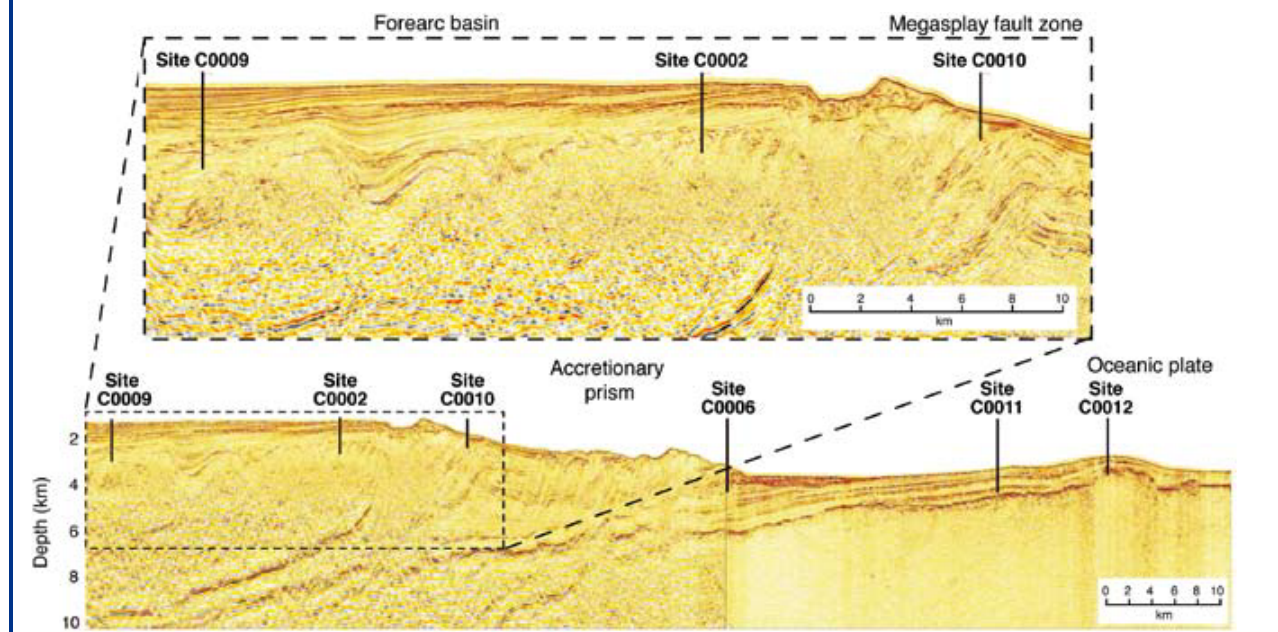
Figure 2. Seismic line across the Nankai margin from 3-D seismic reflection volume showing drill site locations (see also Saffer et al., 2009, 2010 and Fig. 5 for further details of the Kumano forearc basin structure). See Expedition 322 results for details of drilling at Sites C0011 and